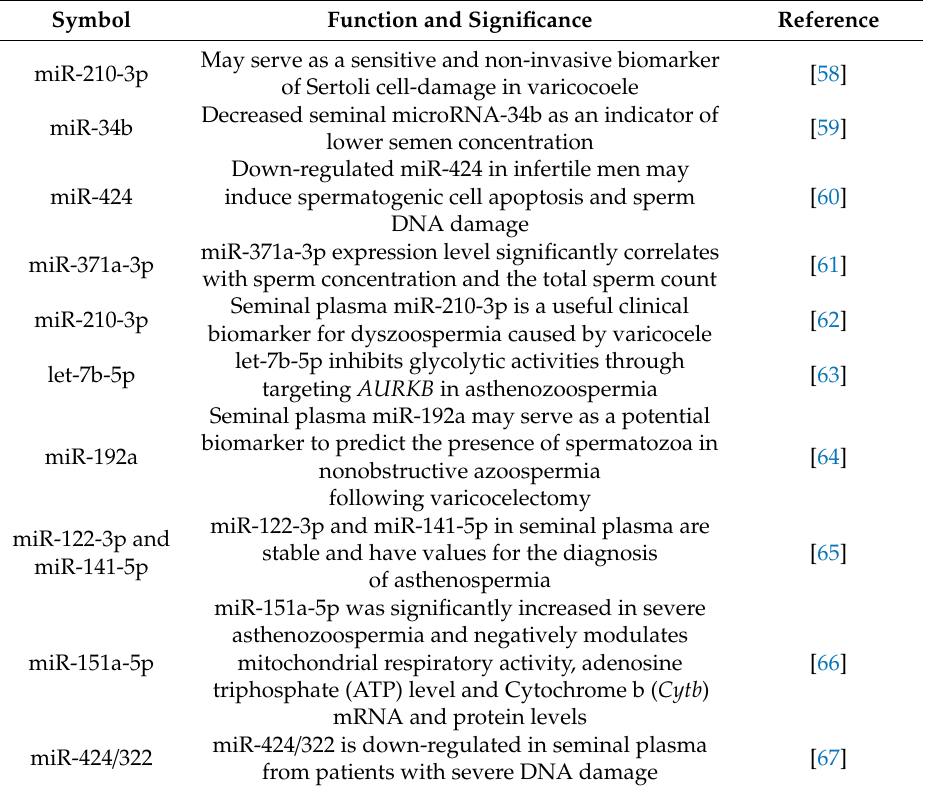
Table 2. Functional microRNAs presented in seminal